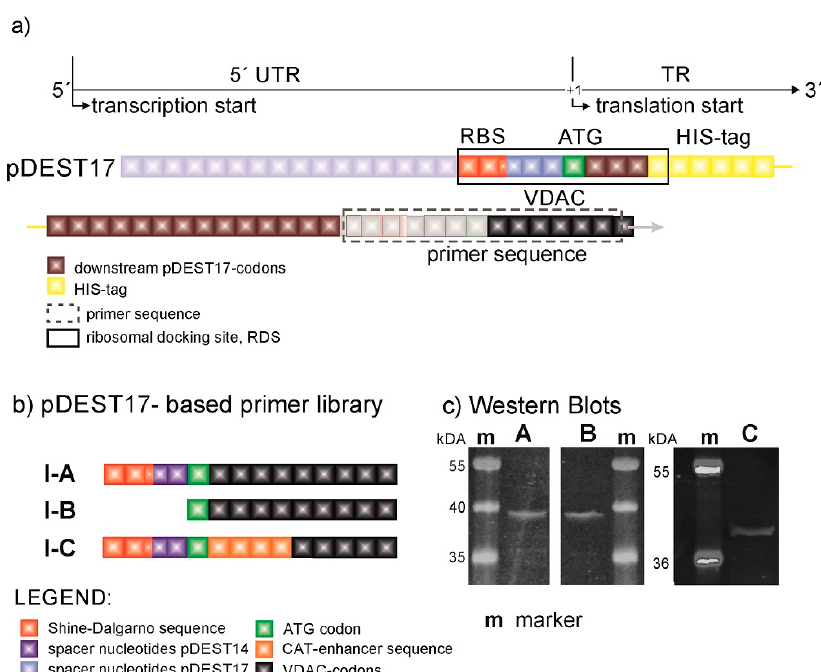
Figure 1. The nucleotide sequence pf PDEST17-based plasmids in the proximity of the start codon. ( a ) Primer library. ( b ) Expression levels (an SDS-page gel fluorescence scan) with a Safe Imager 2.0 TM Blue Light Transilluminator. The emission fluorescence at ≈ 470 nm of the fluorescent lysine accounted for the optical visualization of the protein bands. The respective expression levels were repeatedly achieved in several experiments with no significant difference in the expressed target protein to be observed (additional experiments are shown in the supporting information). ( c ) nc: negative (no plasmid) control. To accommodate for the Gateway ™ strategy, we inserted spacer nucleotides in the primer sequences, according to the manufacturer’s recommendation.